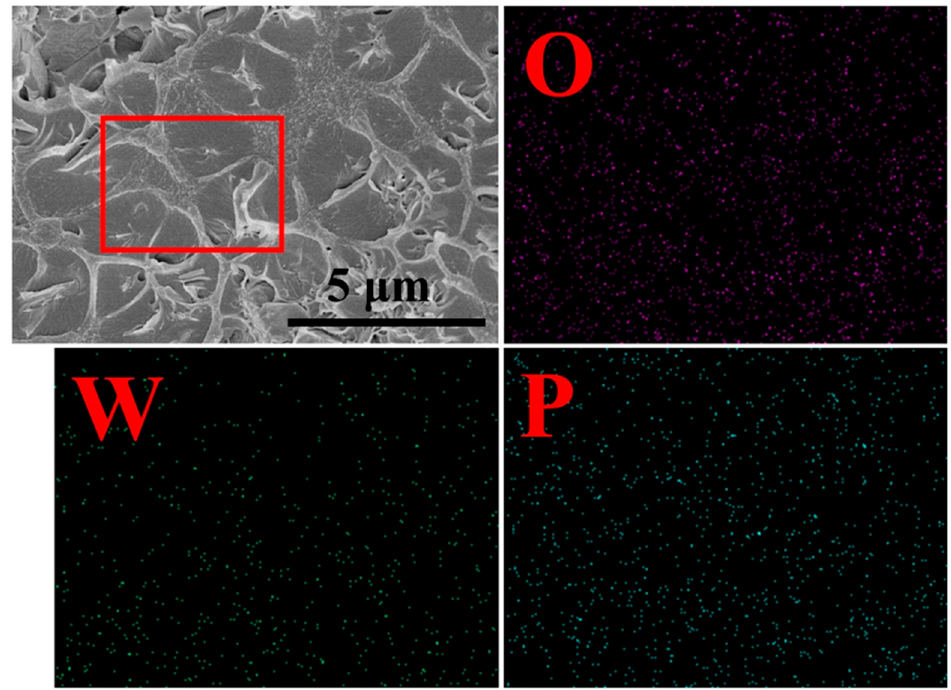
Figure 4. SEM-EDX mapping (element O, W and P) of SPEEK/DGO/DHNTs/HPW (90/5/5/60) composite membrane.